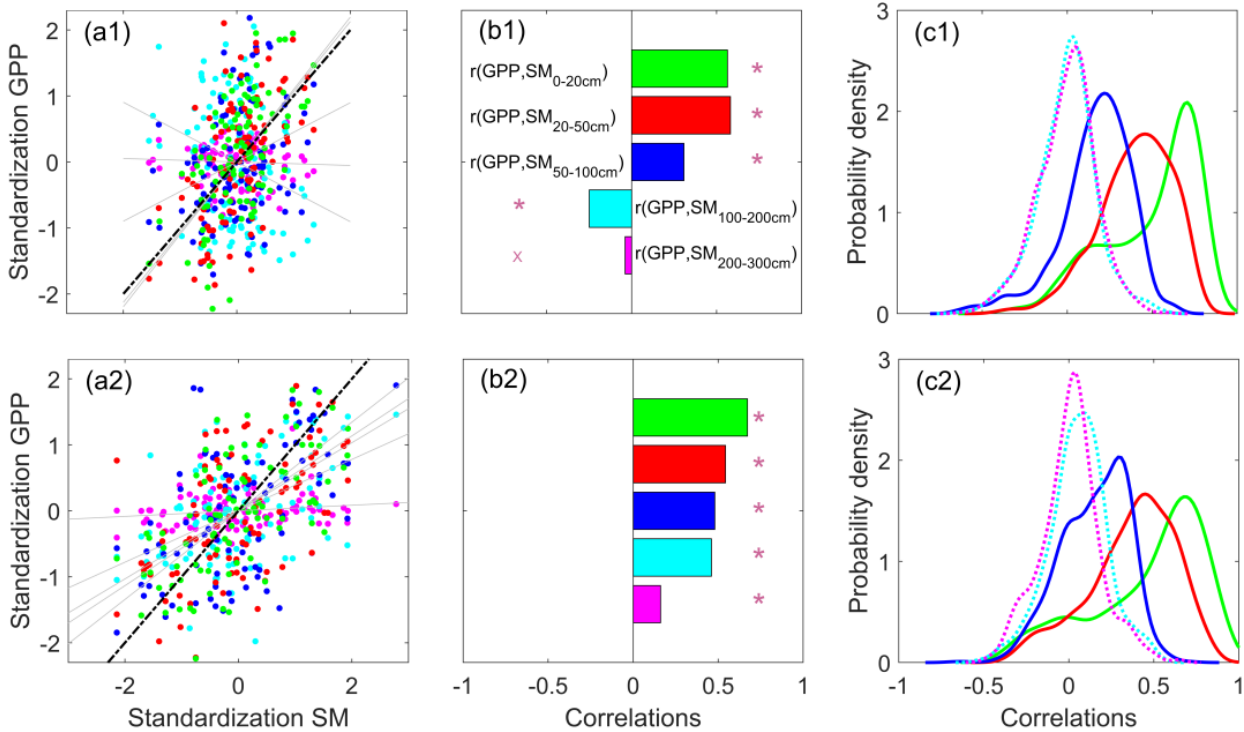
Figure 4. Correlation between warm-season SM and GPP for different soil depths. The upper column is the historical period and the lower column is the future period. ( a1 , a2 ) Scatter plots of SM and GPP per year. Red, green, blue, cyan, and pink represent soil moisture at 0–20 cm, 20–50 cm, 50–100 mm, 100–200 mm, and 200–300 mm soil depths, respectively; ( b1 , b2 ) correlation between SM and GPP regional averages; ( c1 , c2 ) probability density plot of correlation between SM and GPP.